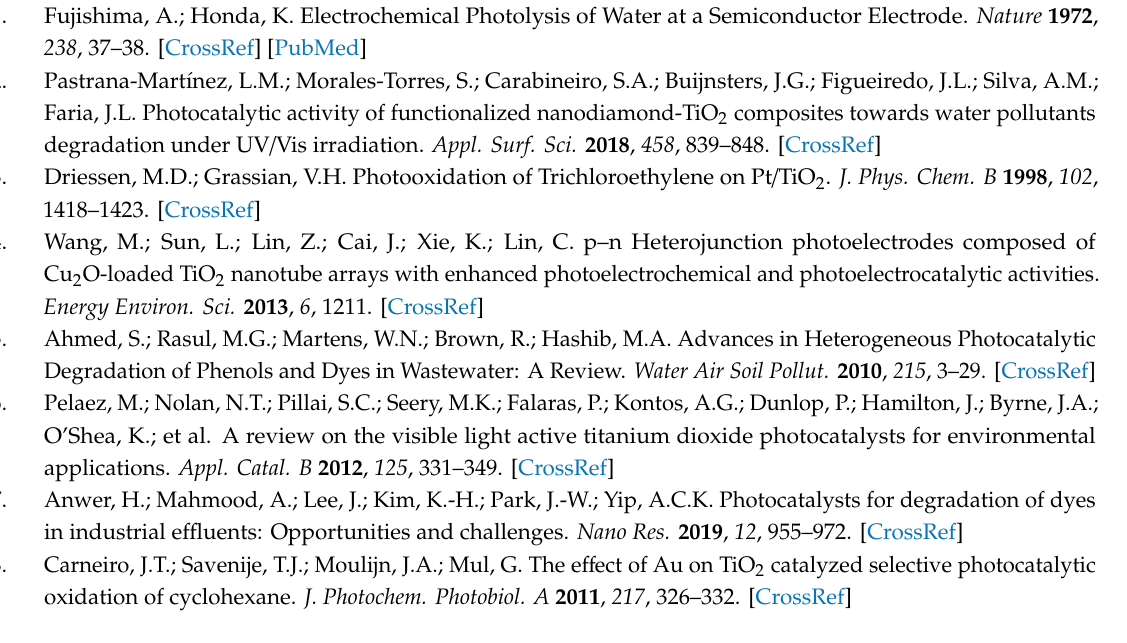
Figure S1: TEM pictures of Pt:P25 and SiO2:25, Figure S2: raw data photocatalytic activity, Figure S3: XRD spectra, Figure S4: UV / Vis DRS spectra, Figure S5: dye adsorption on catalyst